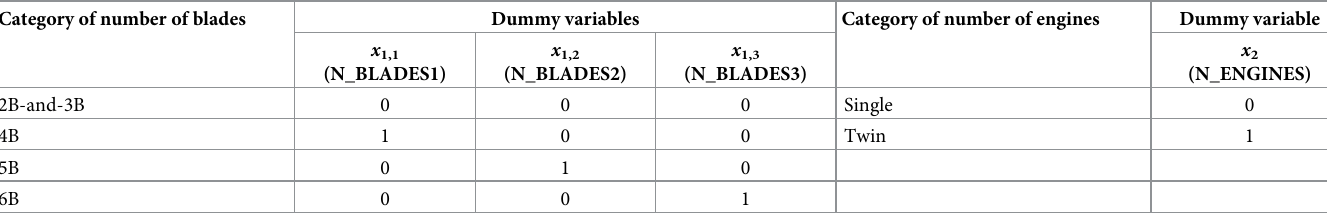
Table 2. The dummy variables and their value for each category used in this analysis.